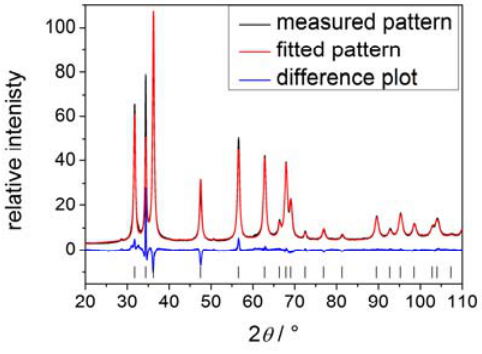
Figure 3. X-ray powder pattern of the obtained particles. The results show that pure zinc oxide was obtained.